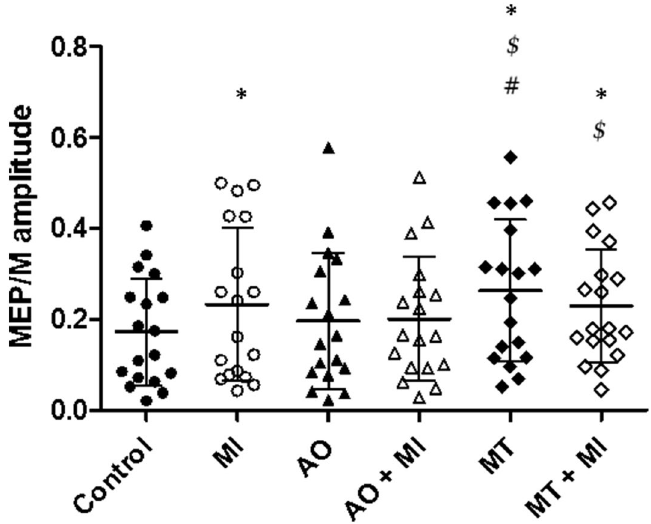
Figure 2. Comparison of normalized MEP amplitude between conditions. Individual data as well as group mean and standard deviation are presented for control, motor imagery (MI), action observation (AO), AO + MI, mirror therapy (MT) and MT + MI conditions. * indicates significant difference. $ indicates significant difference compared to AO. # indicates significant difference compared to AO +